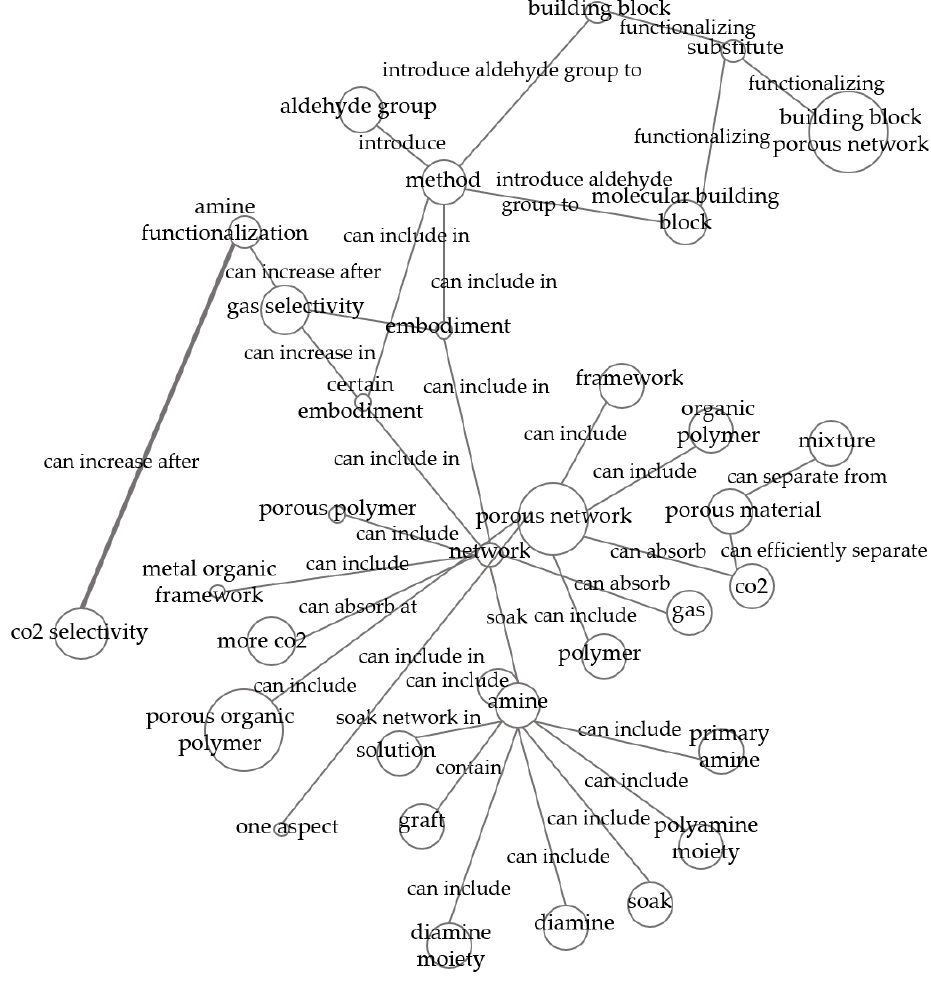
Figure 9. Summary graph of US9663627B2.